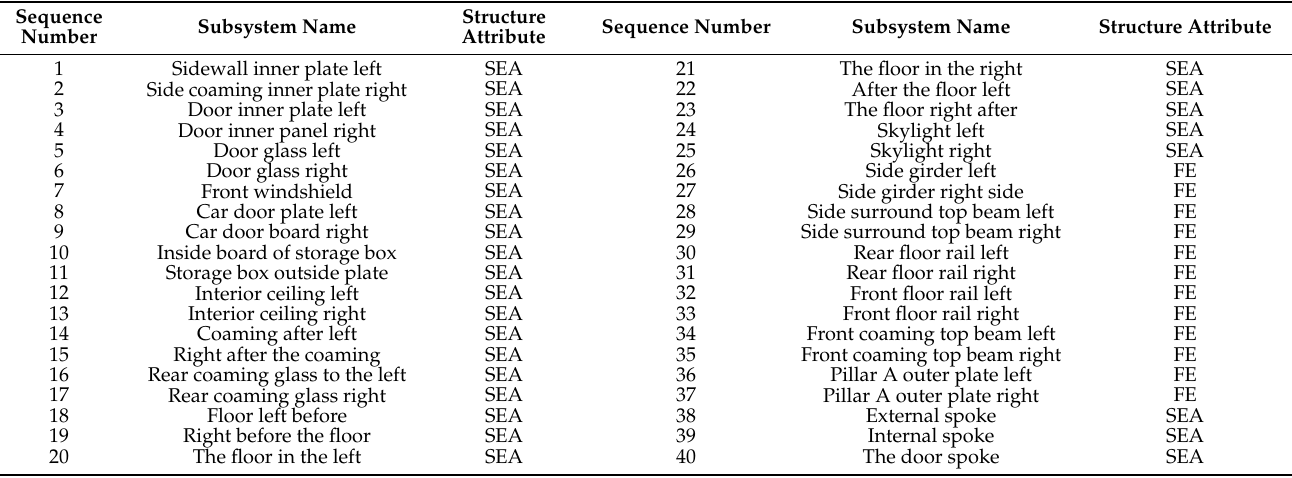
Table 1. Commercial vehicle cab subsystem